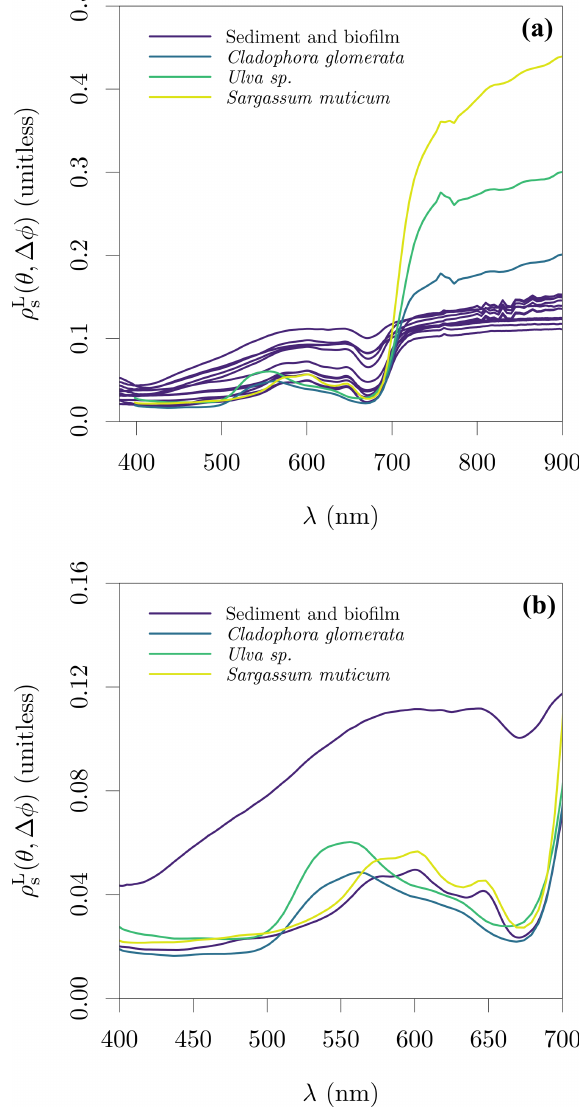
Figure 10. Lambert-equivalent substrate bi-hemispherical re- flectance, ρ L s , estimated from samples on the Spuikom. The view geometry was nadir view ( θ = 0 ◦ , (cid:49)φ undefined) for all measure- ments. (a) The magnitude of ρ L s in the visible to NIR spectral range and (b) the magnitude in the visible spectral range. In panel (b) , only the sediment samples with the thinnest and thickest biofilm mats are shown, as judged by the reflectance magnitude at